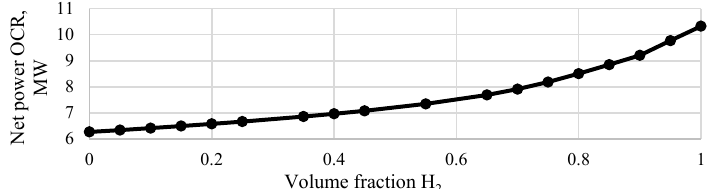
Figure 13. Dependence of the ORC output power on the hydrogen volume fraction.